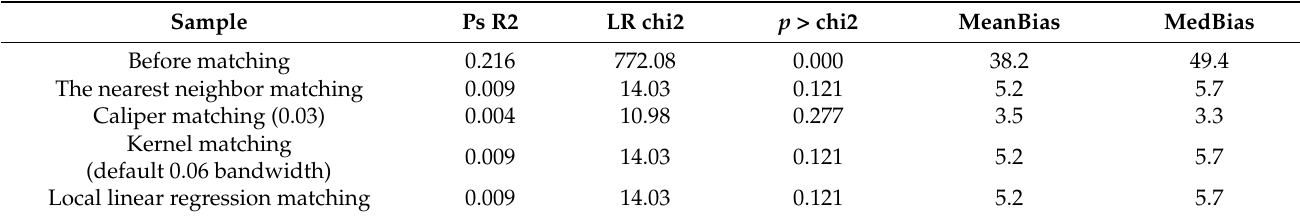
Table 8. Results of balance test.